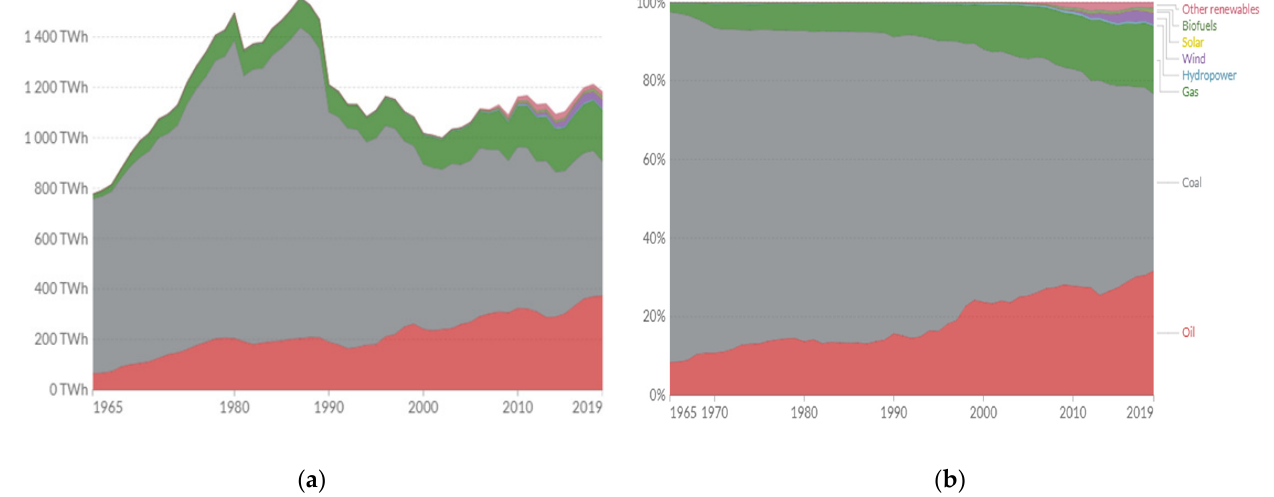
Figure 6. Poland primary energy consumption by source: ( a ) in TWh; ( b ) relative (%) [1]. Table 3. Weighted SWOT matrix for the Polish energy